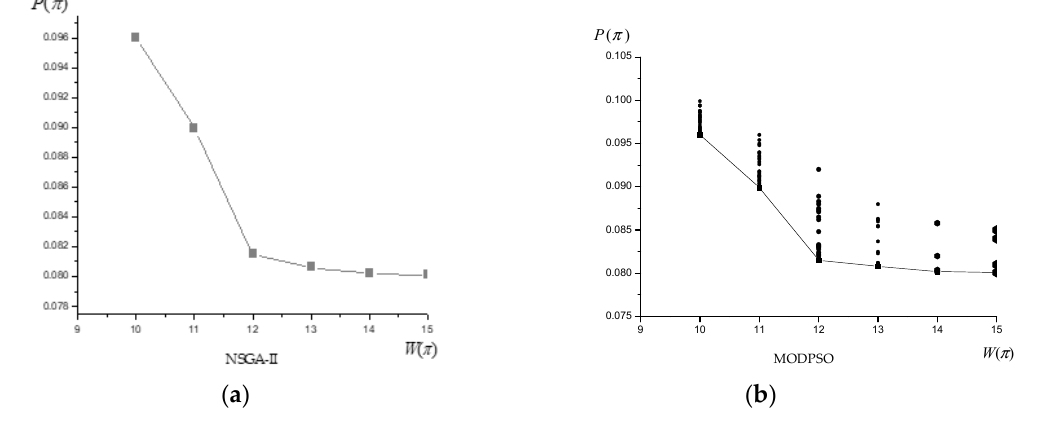
Figure 4. Results of the two algorithms.